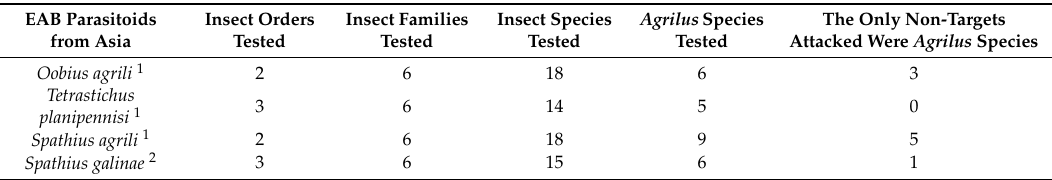
Table 2. Non-target insect taxa tested with the Asiatic parasitoids petitioned for environmental release in North America as EAB biocontrol